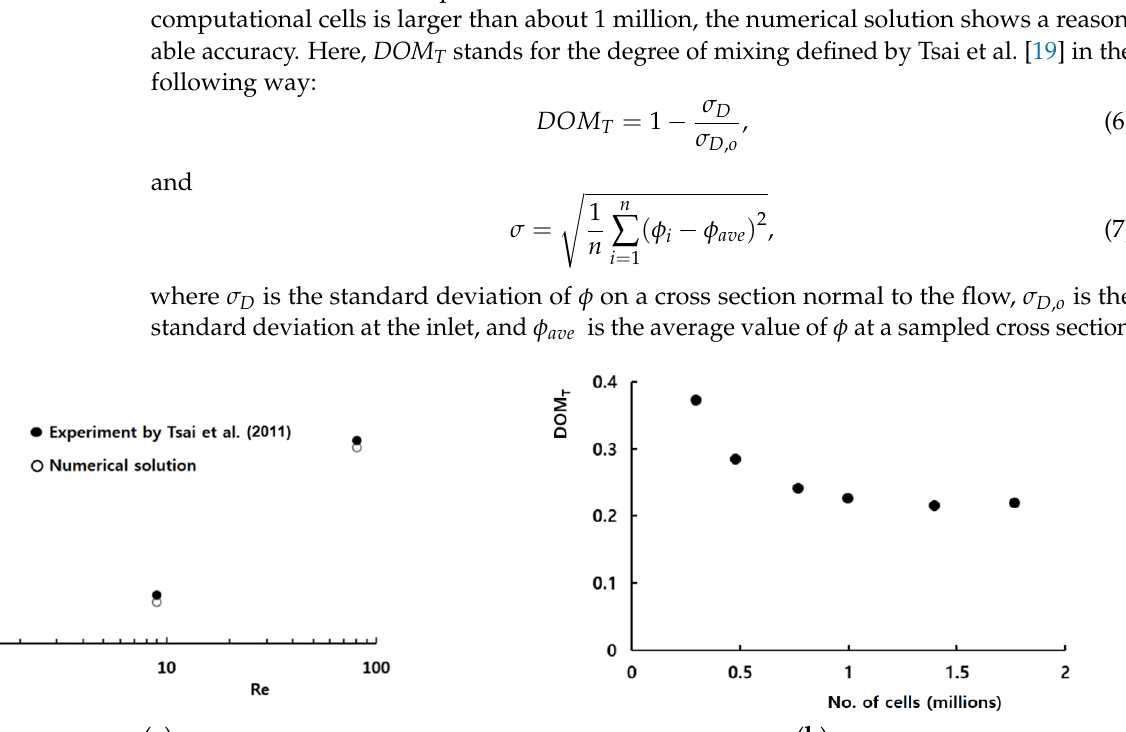
Figure 3. Diagram of the micromixer tested by Tsai et al. [19].